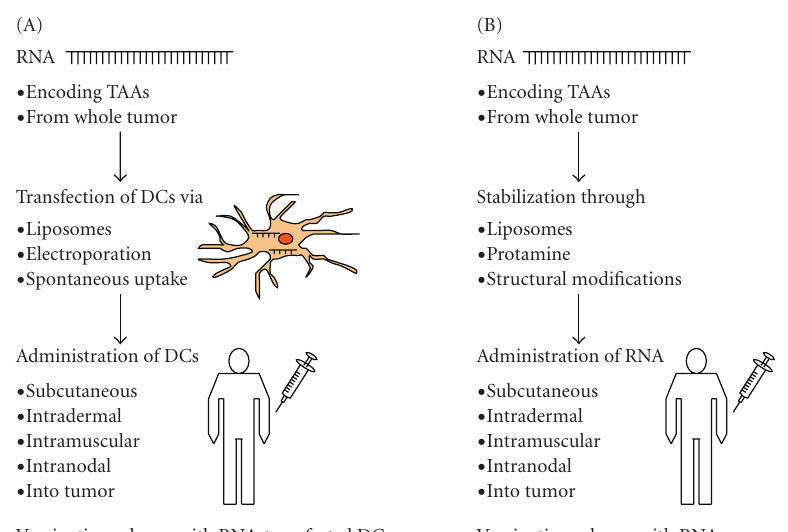
Figure 1: Overview over RNA-vaccination schemes using DCs (A) or pure/stabilized